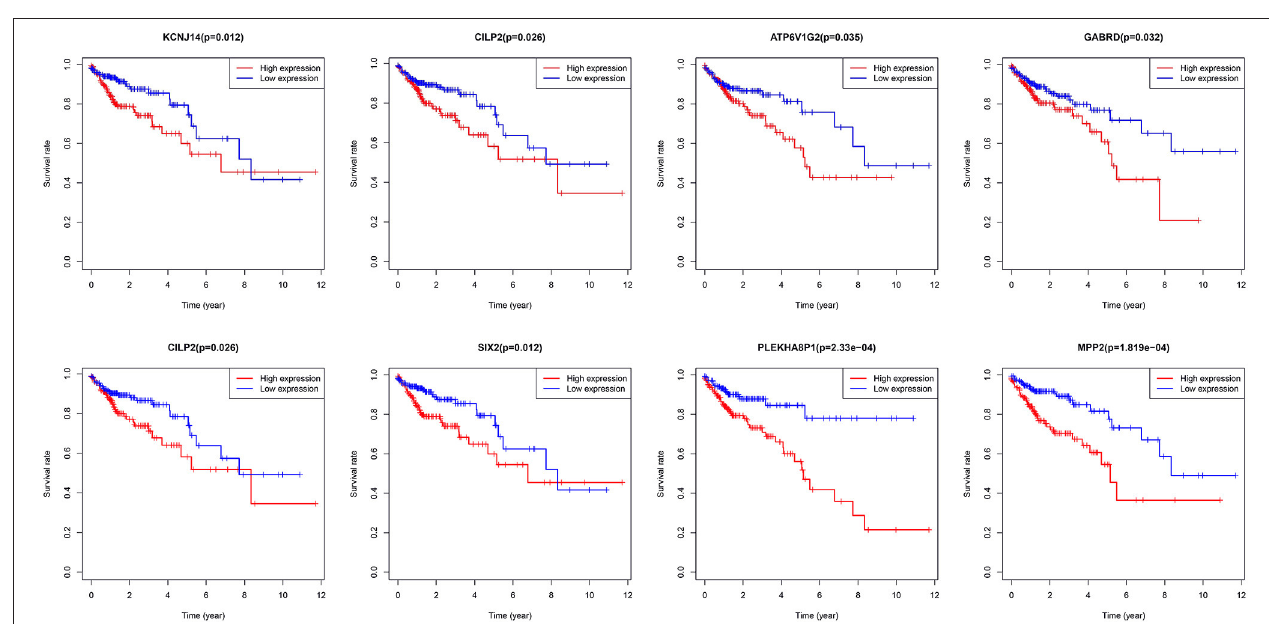
Frontiers in Surgery |